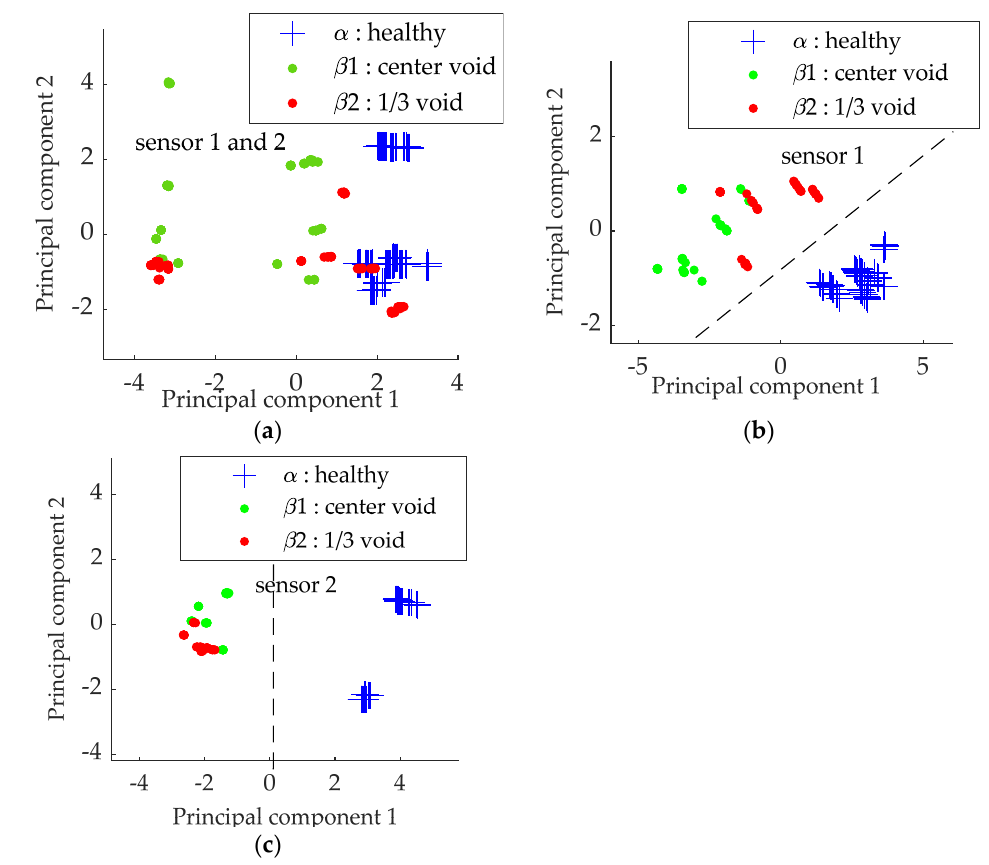
Figure 5. First principal component as a function of second principal component for α , β 1 and β 2 samples obtained with: ( a ) sensor 1 and 2 data; ( b ) sensor 1 data only; ( c ) sensor 2 data only.